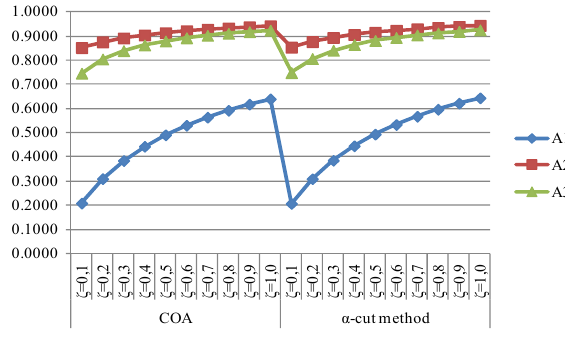
Figure 3. Variation analysis of ζ and defuzzification method value for each alternative